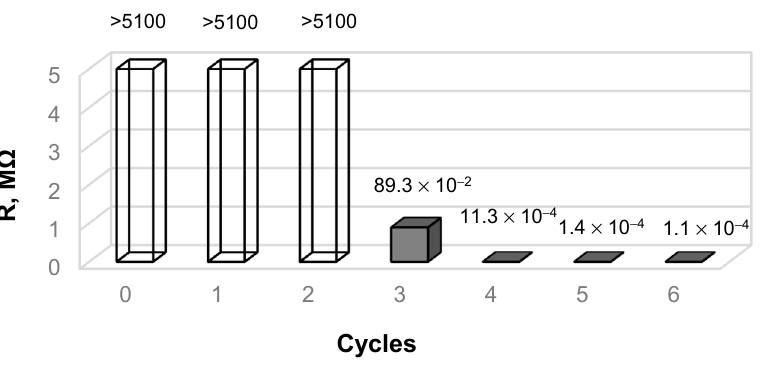
Figure 3. Resistance measurement.